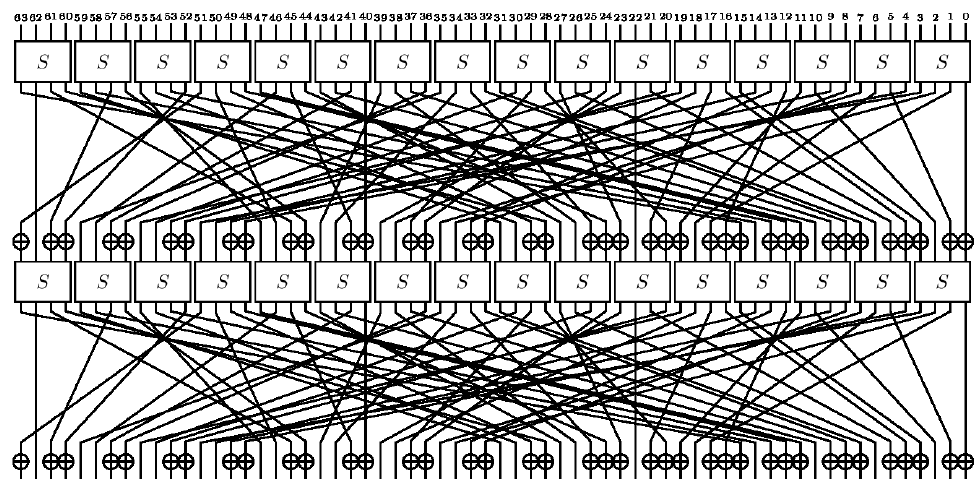
Figure 1: 2 rounds of GIFT-64 (from https://www.iacr.org/authors/tikz/